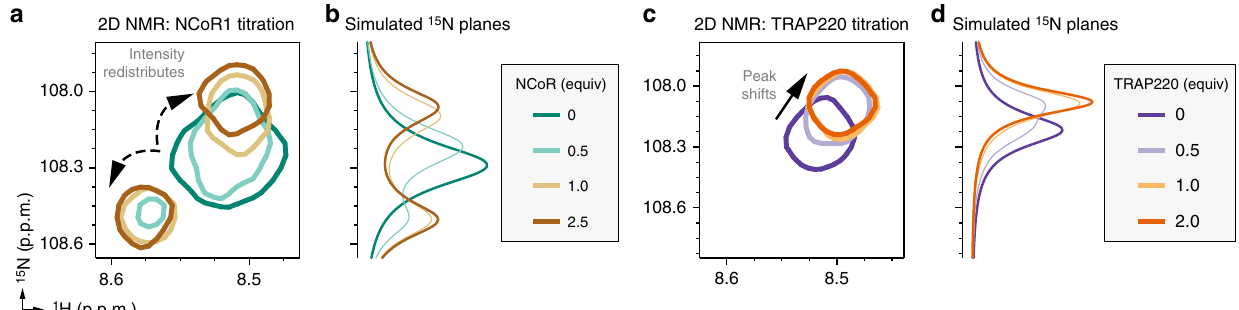
Fig. 8 Coregulator binding preferences of the single GW9662-bound conformation detected by NMR. a Snapshot overlay of 2D [ 1 H, 15 N]-TROSY-HSQC spectra of GW9662-bound 15 N-labeled PPAR γ LBD titrated with NCoR1 peptide. b The 15 N spectral planes of the 2D NMR titration are quantitatively described using a 3-state model (R + P ↔ RP ↔ R*P) where PPAR γ LBD bound to GW9662 and NCoR1 slowly isomerizes between two states (RP and R*P). c Snapshot overlay of 2D [ 1 H, 15 N]-TROSY-HSQC spectra of GW9662-bound 15 N-labeled PPAR γ LBD titrated with TRAP220 peptide. d The 15 N spectral planes of the 2D NMR titration are quantitatively described using a 2-state model (R + P ↔